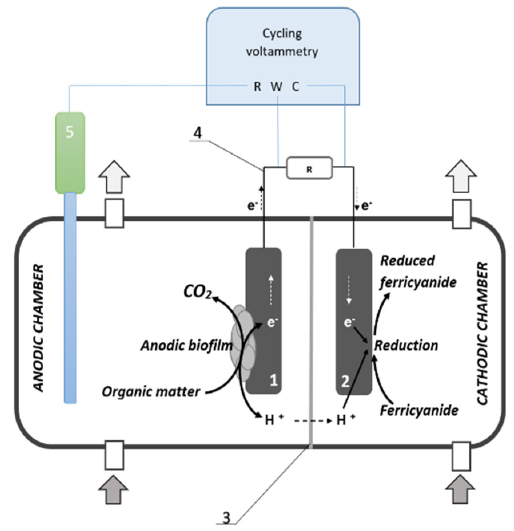
Figure 3. MFC reactor configuration and experimental design used during the COD removal experiments; 1—anode, 2—cathode, 3—PEM, 4—external circuit and resistor, 5—reference electrode